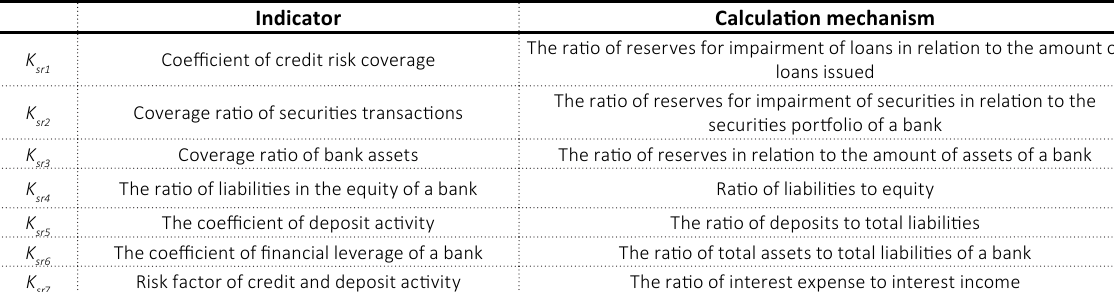
Table 2. Indicators of risk in the bank activities